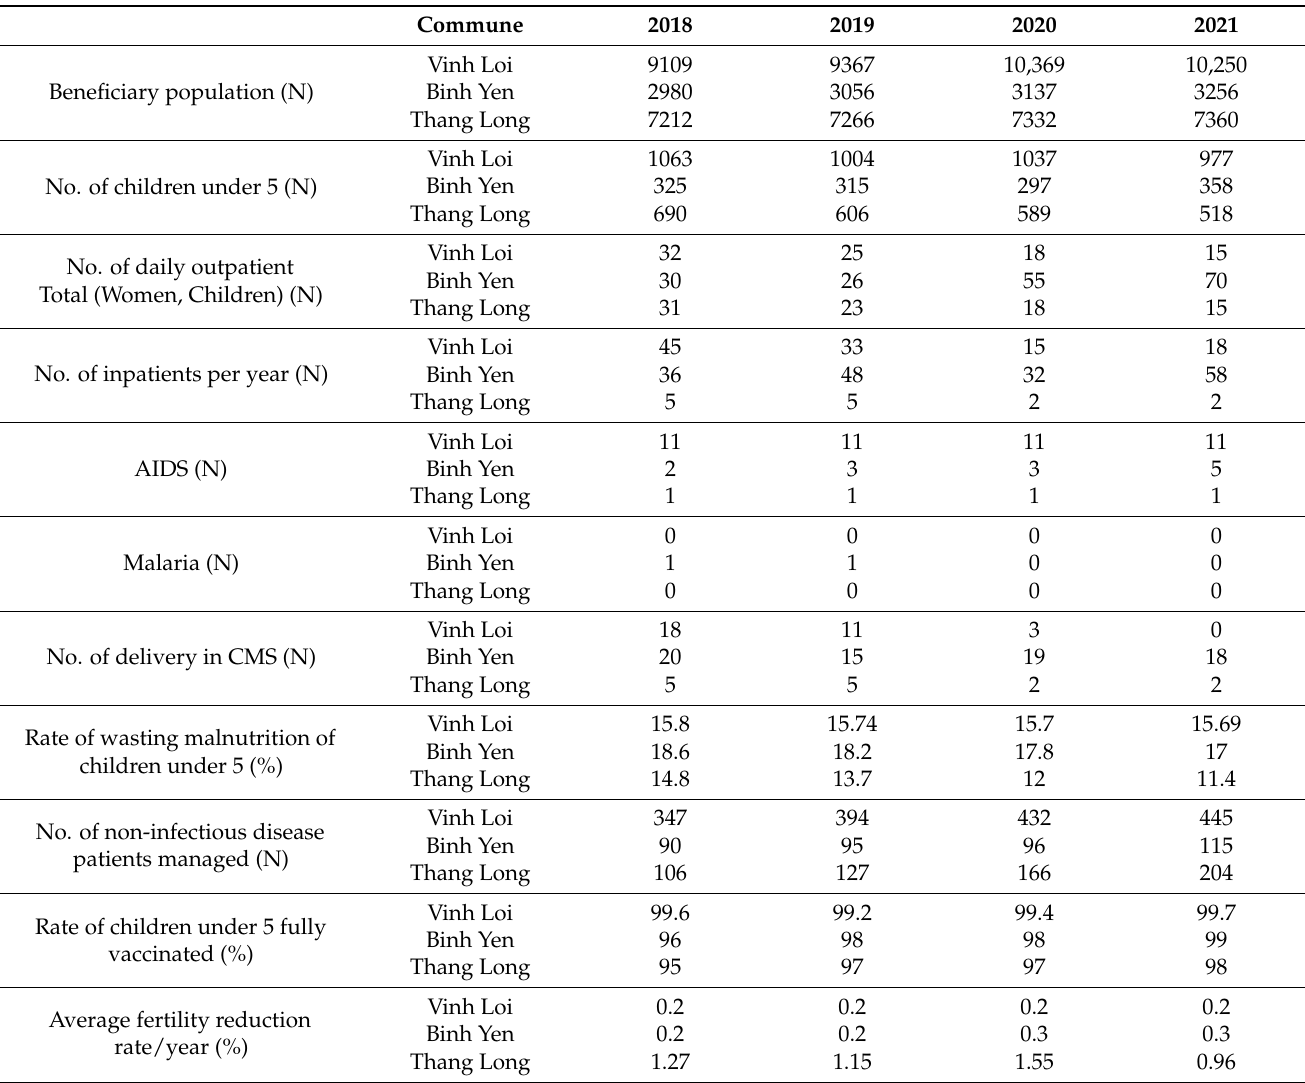
Table 8. Healthcare services utilization at the three different CHSs in Tuyen Quang province, Vietnam from